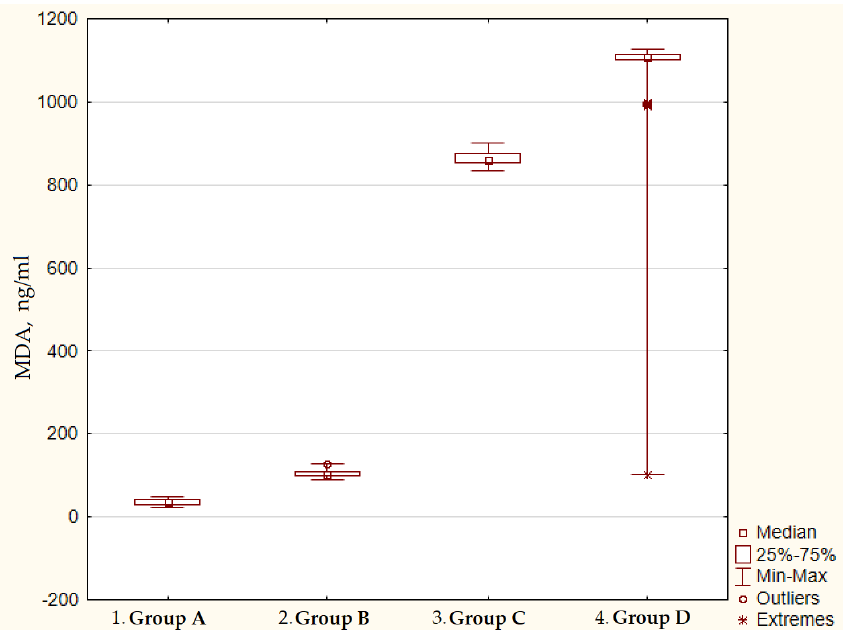
Figure 2. The content of malonic dialdehyde in the blood plasma of patients with atrophic gastritis and gastric cancer.